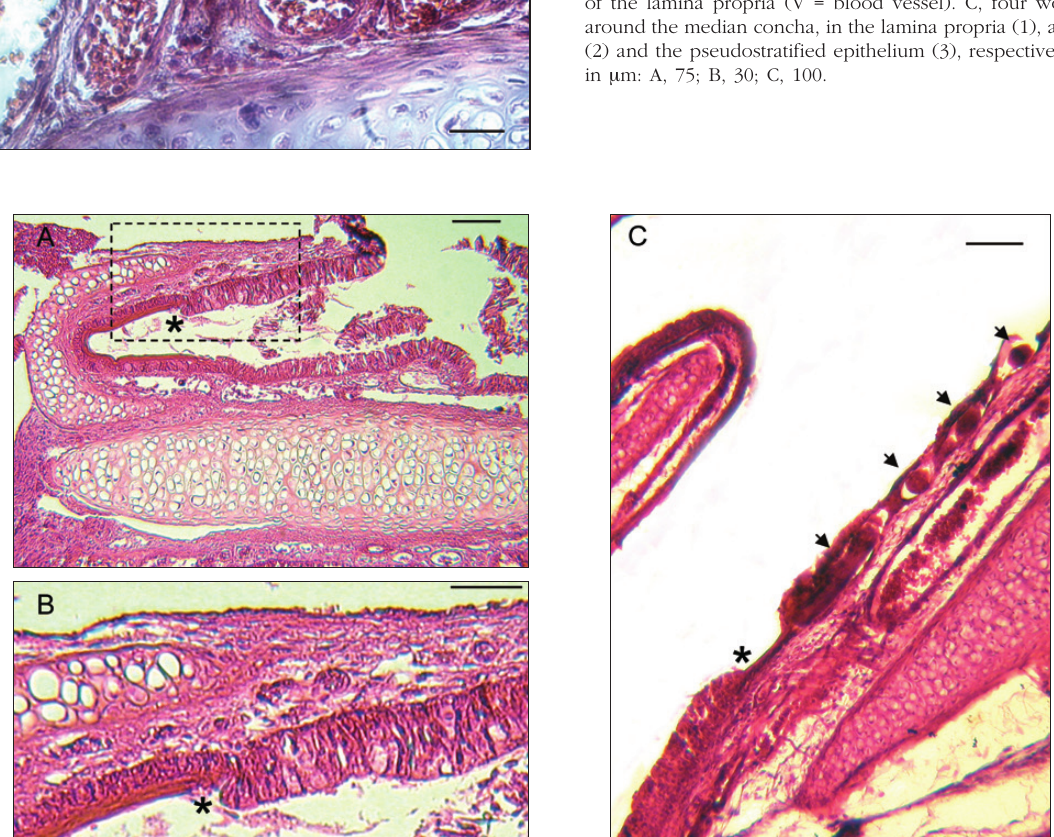
Fig. 5. – Trichosomoides nasalis (arrows) in tissues of the nasal cavi- ties. A, in the lamina propria, a worm in longitudinal section, at level of stichocytes. Note the large longitudinal vessel below, and another worm on left in the connective tissue. B, worm in a blood vessel of the lamina propria (V = blood vessel). C, four worms situated around the median concha, in the lamina propria (1), a blood vessel (2) and the pseudostratified epithelium (3), respectively. Scale bars in μ m: A, 75; B, 30; C, 100.